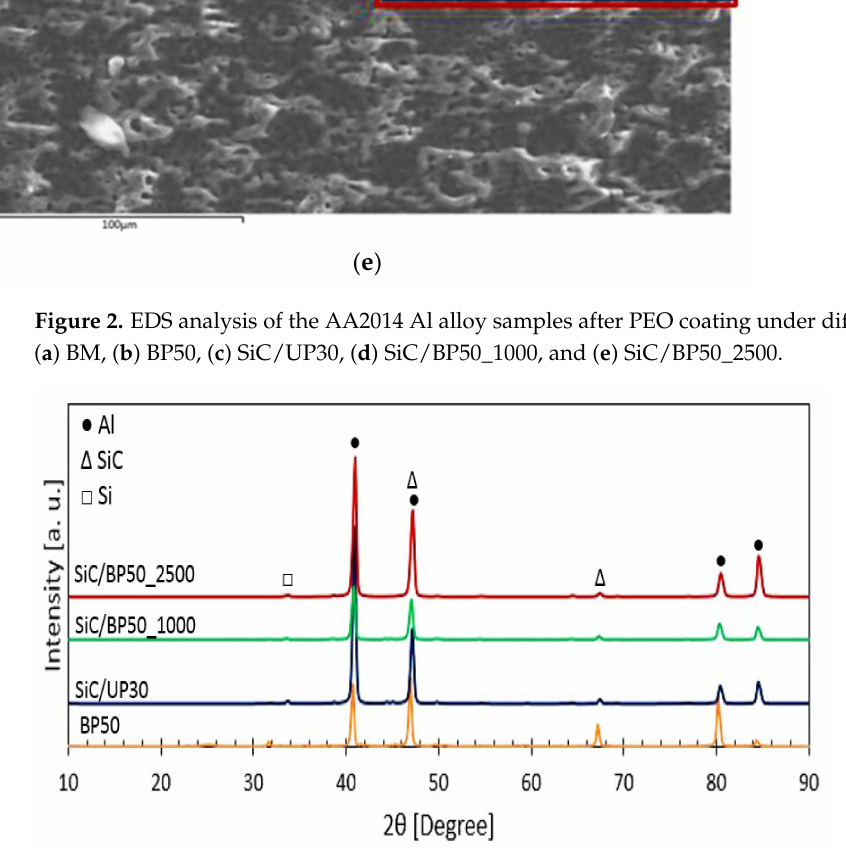
Figure 3. XRD patterns of the AA2014 Al alloy samples’ substrate after coating under different